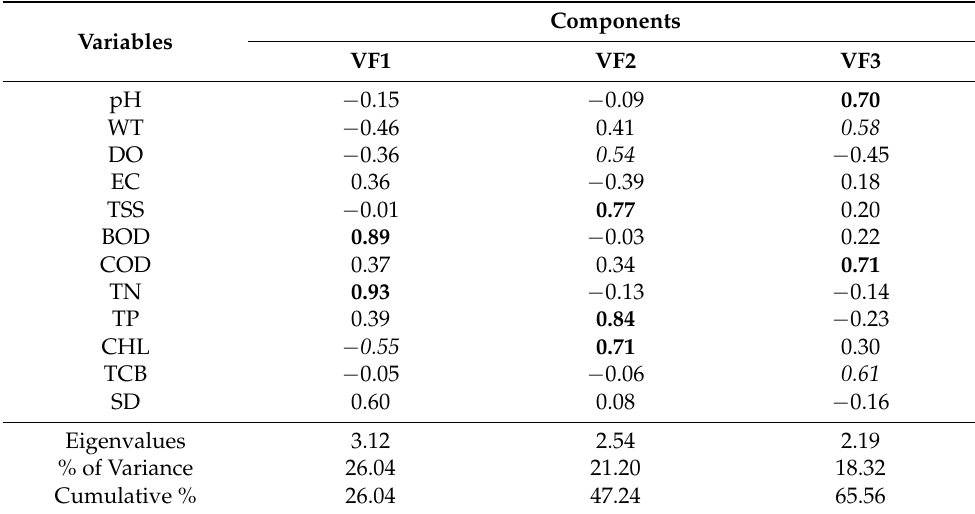
Table 3. Principal component analysis of water quality parameters.